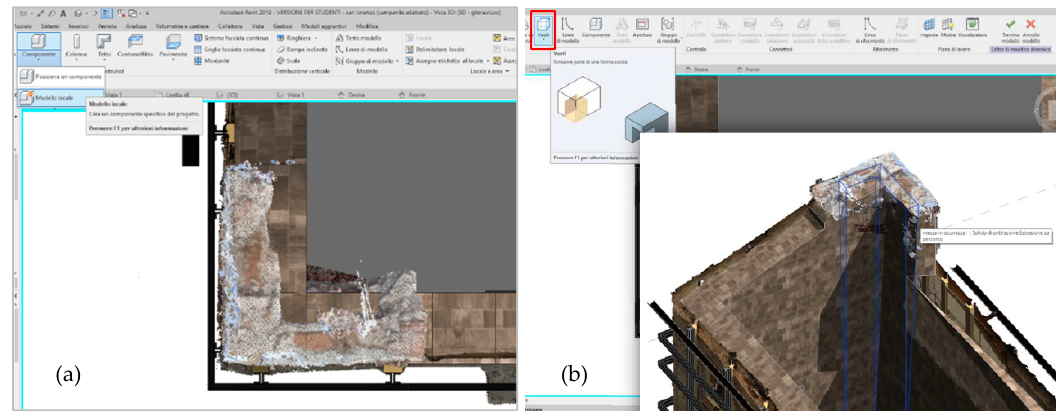
Figure 8. (a): t he overlapped point cloud on the wall. (b): the subtraction of the volume for narrowing Figure 8. ( a ) The overlapped point cloud on the wall. ( b ) The subtraction of the volume for narrowing the thickness of the wall. the thickness of the